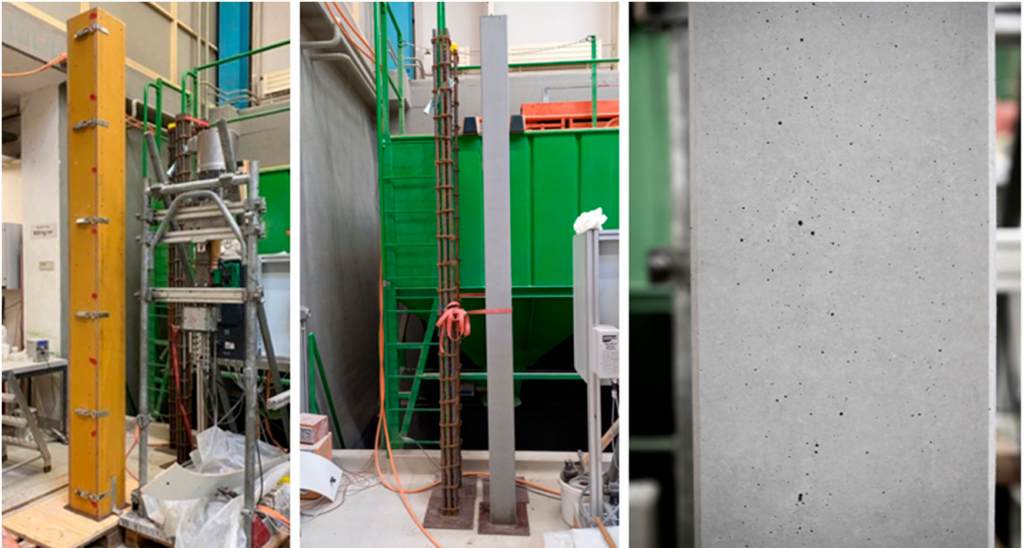
Figure 9. High-strength reinforced concrete column. From left to right: wooden formwork 150 × 150 mm, middle reinforcement cage provided by industry partner, result of casted column.